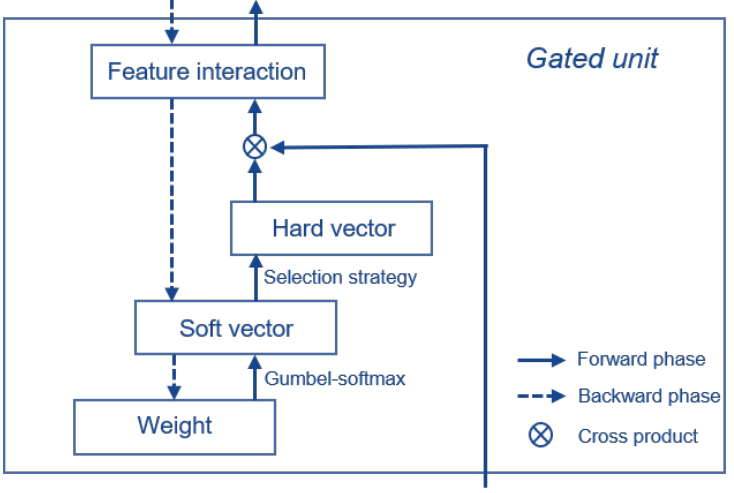
Figure 2. Data flow of a gated unit. Solid line and dashed line denote forward phase and backward phase of training, respectively. At the beginning of training, weights of feature fields are randomly initialized. In the forward phase, “soft” vector is calculated using the trick of Gumbel-softmax, and then “hard” vector is calculated using feature selection strategy. After that, the selected features can participate in interaction. In the backward phase, the gradients are backpropagated step by step, skipping the “hard”